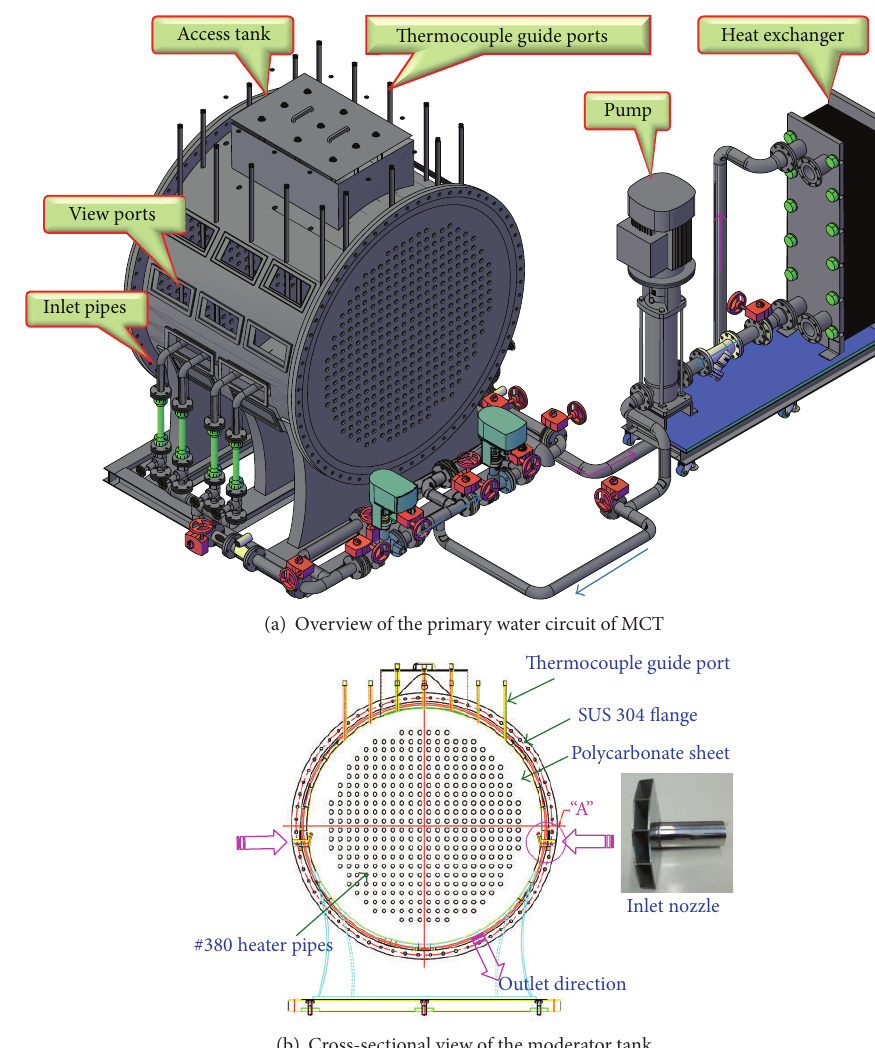
Figure 2: Geometric configuration of the MCT